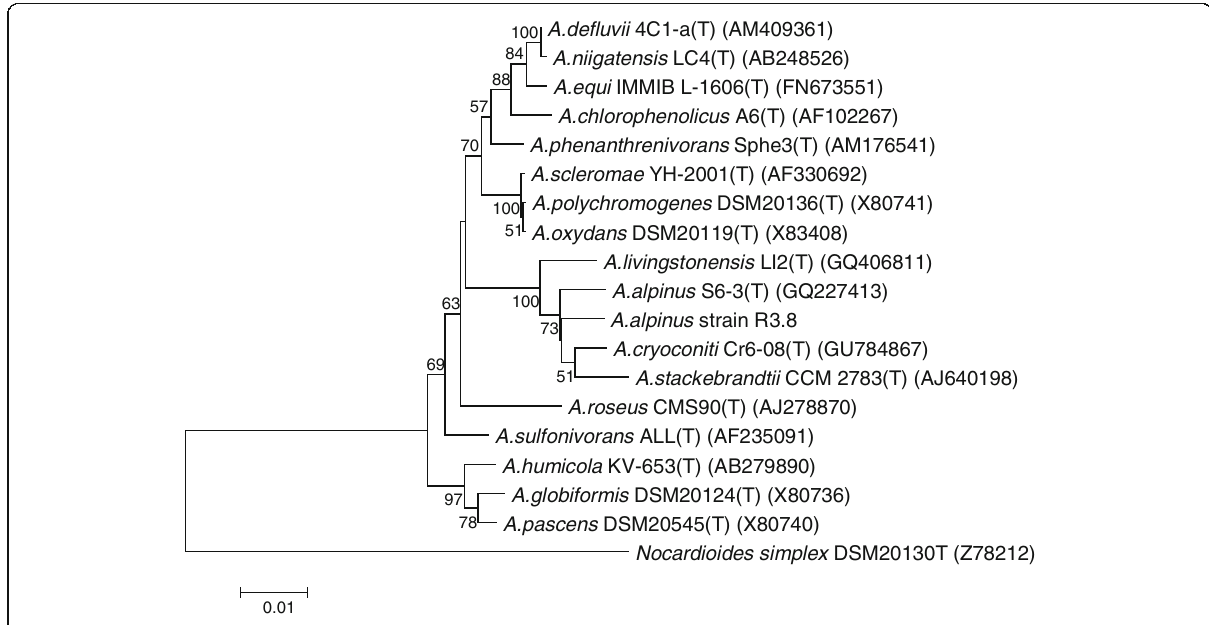
Fig. 1 Neighbour-joining phylogenetic tree based on complete 16S rRNA gene sequences of Arthrobacter alpinus strain R3.8 and closely related species of the genus Arthrobacter . Bootstrap values (expressed as percentages of 1000 replications) are shown at the branching points . Bar, 1 nt substitutions per 100 nt